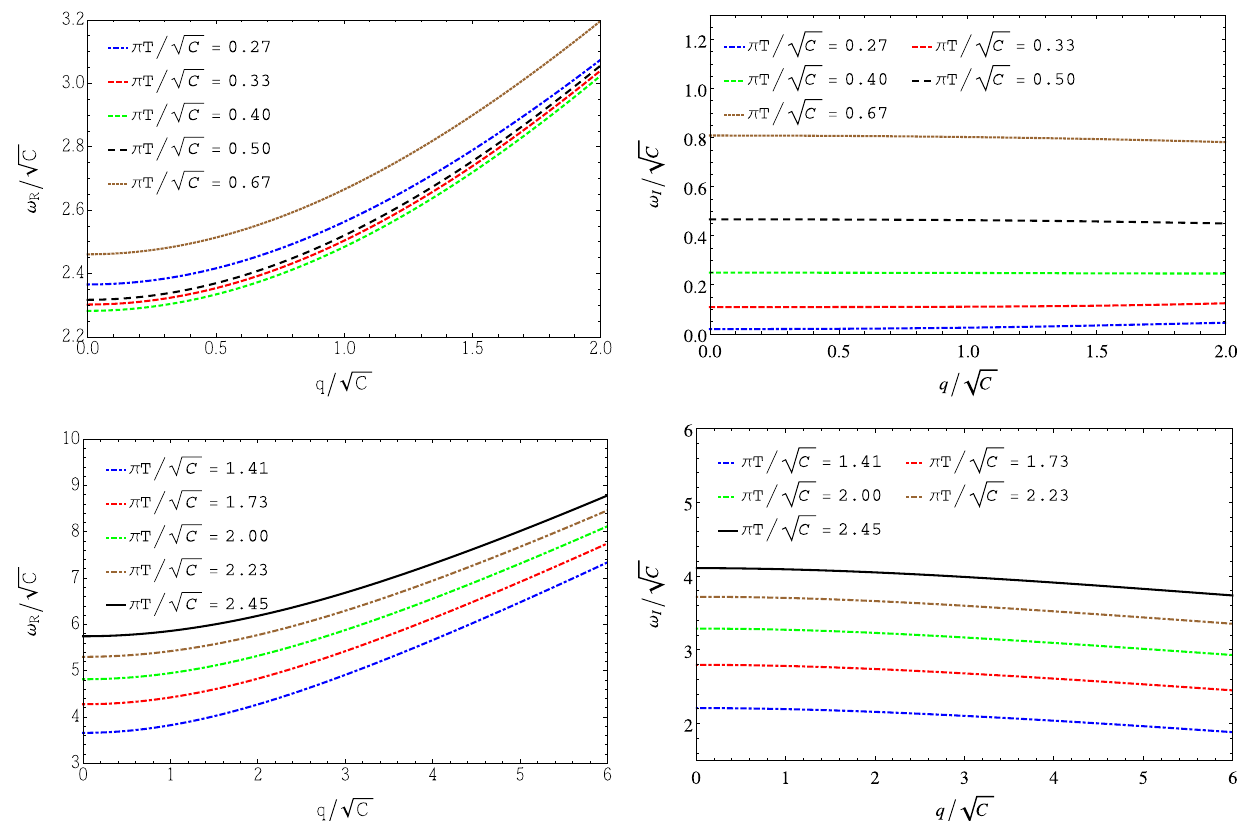
Fig. 12 Dispersion relations for low temperatures (top panels), intermediate and high temperatures (bottom panels) for G = 50